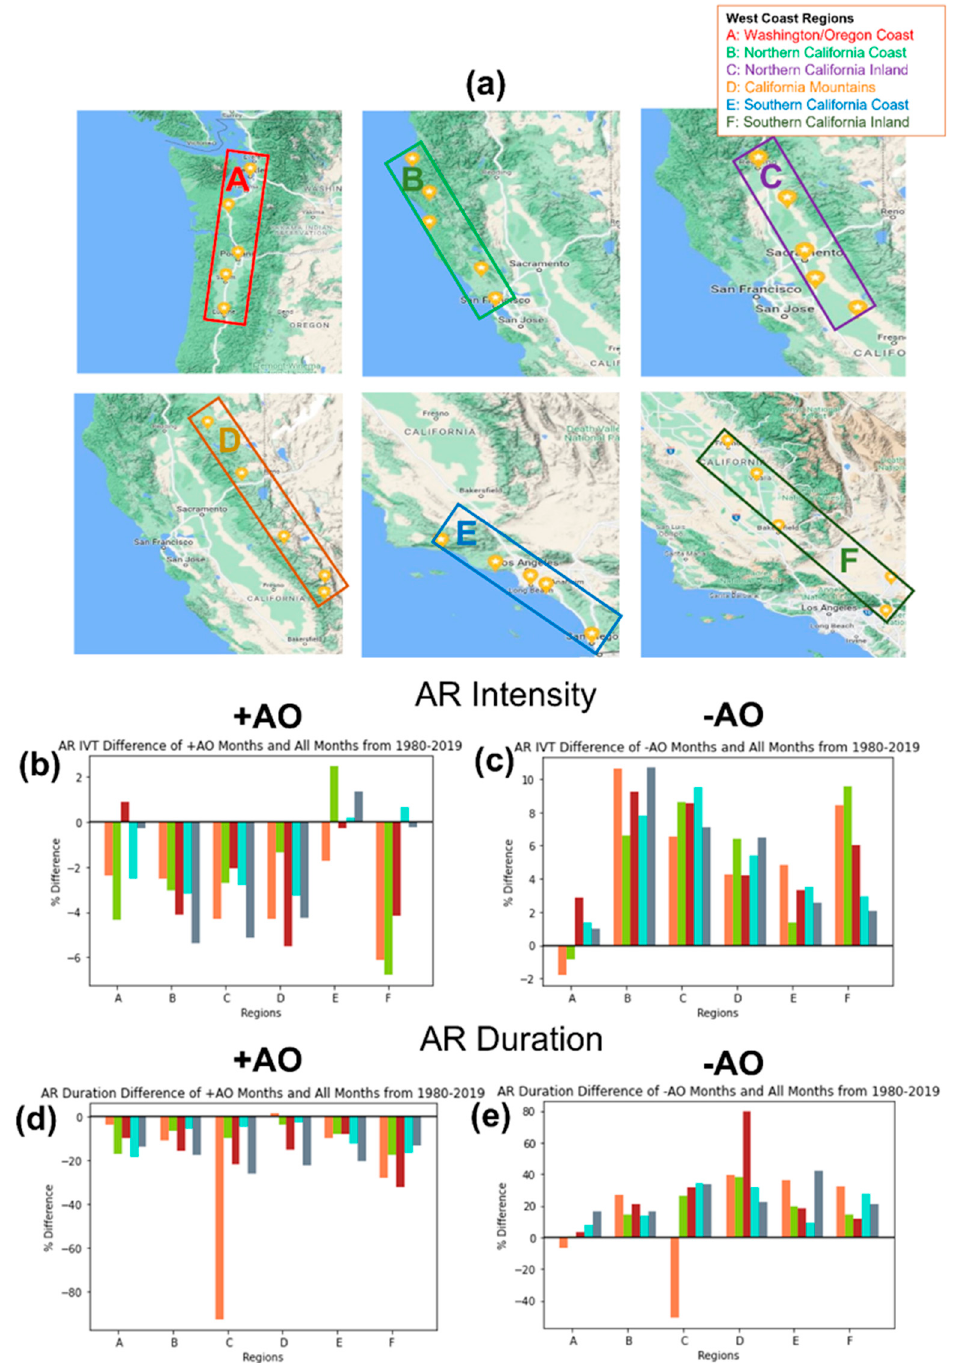
Figure 6. ( Top ) Map of study regions created using Google Maps© ( a ). ( Bottom ) Percentage difference histograms of ( b , c ) AR intensity and ( d , e ) AR duration during positive AO months and negative AO months from October through April during 1980–2019. The intensity is determined by the magnitude of IVT values. The different colors in the histogram indicate the values at different sites from the northeast to the southwest (from left to right) for each subregion (A–F). The negative values represent a percentage lower than the climatological mean (1980–2019), and the positive values represent a percentage higher than the climatological mean.